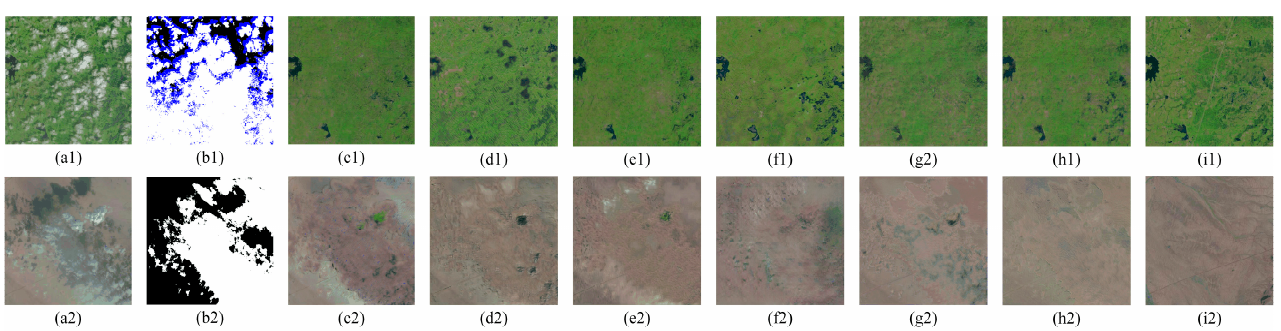
91.2 ↑ : The higher score indicates the better effect. The best value of each indicator is highlighted in bold.